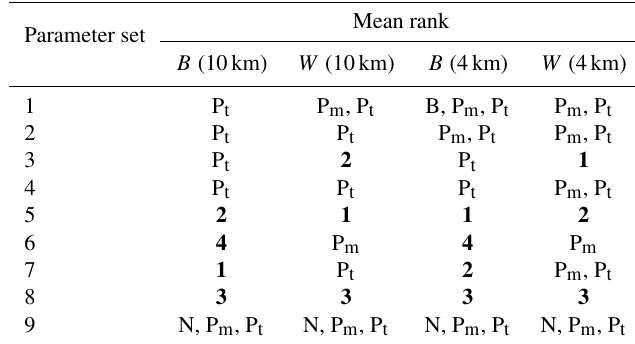
Figure A1. Parameter sets used in checking the transferability of calibration at 10 and 4km spatial resolutions. Table A1. Summary of mean ranks for each parameter set at 10 and 4km spatial resolution. Abbreviated codes indicate that the parameter set had been screened out in at least one of the criteria used for